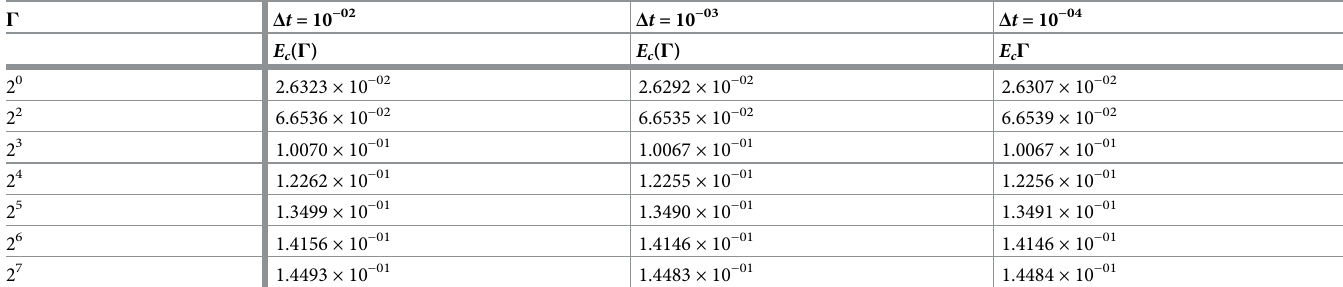
Table 2. The MAEs for � k ¼ 0 : 35 and t = 1 for Test Problem 1.